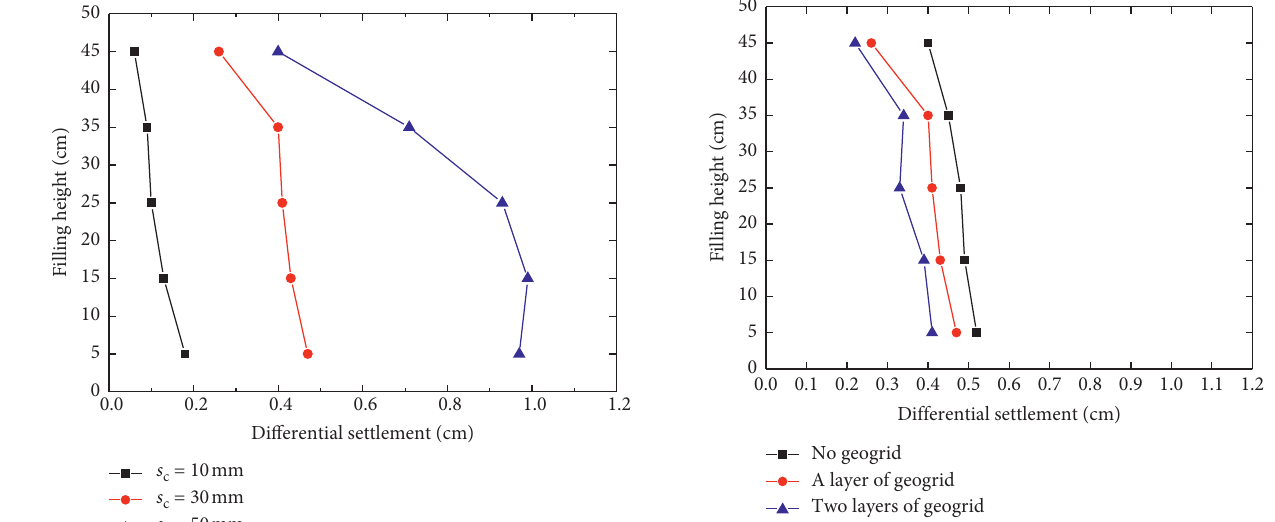
Figure 8: Variation of the differential settlement with filling height under different reinforced